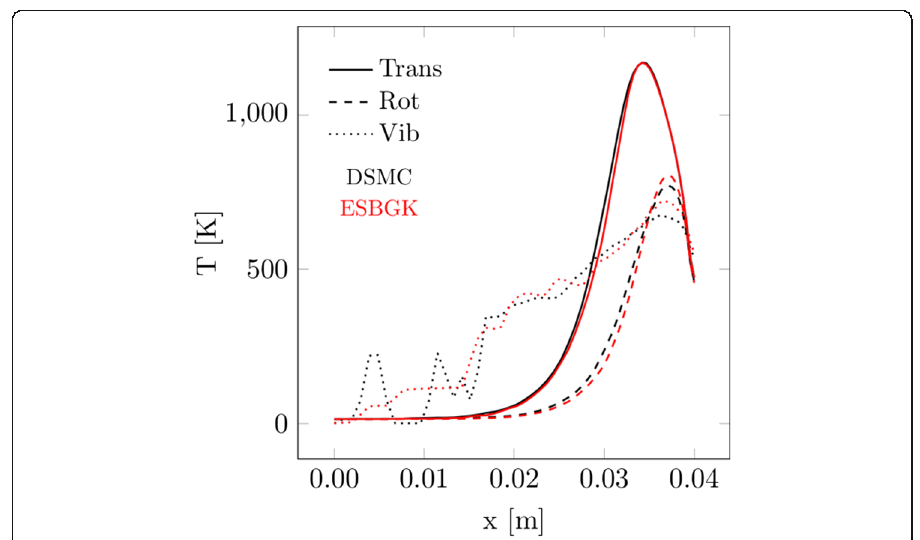
Fig. 5 Distribution of temperature over stagnation stream line. Both the ESBGK and DSMC results are